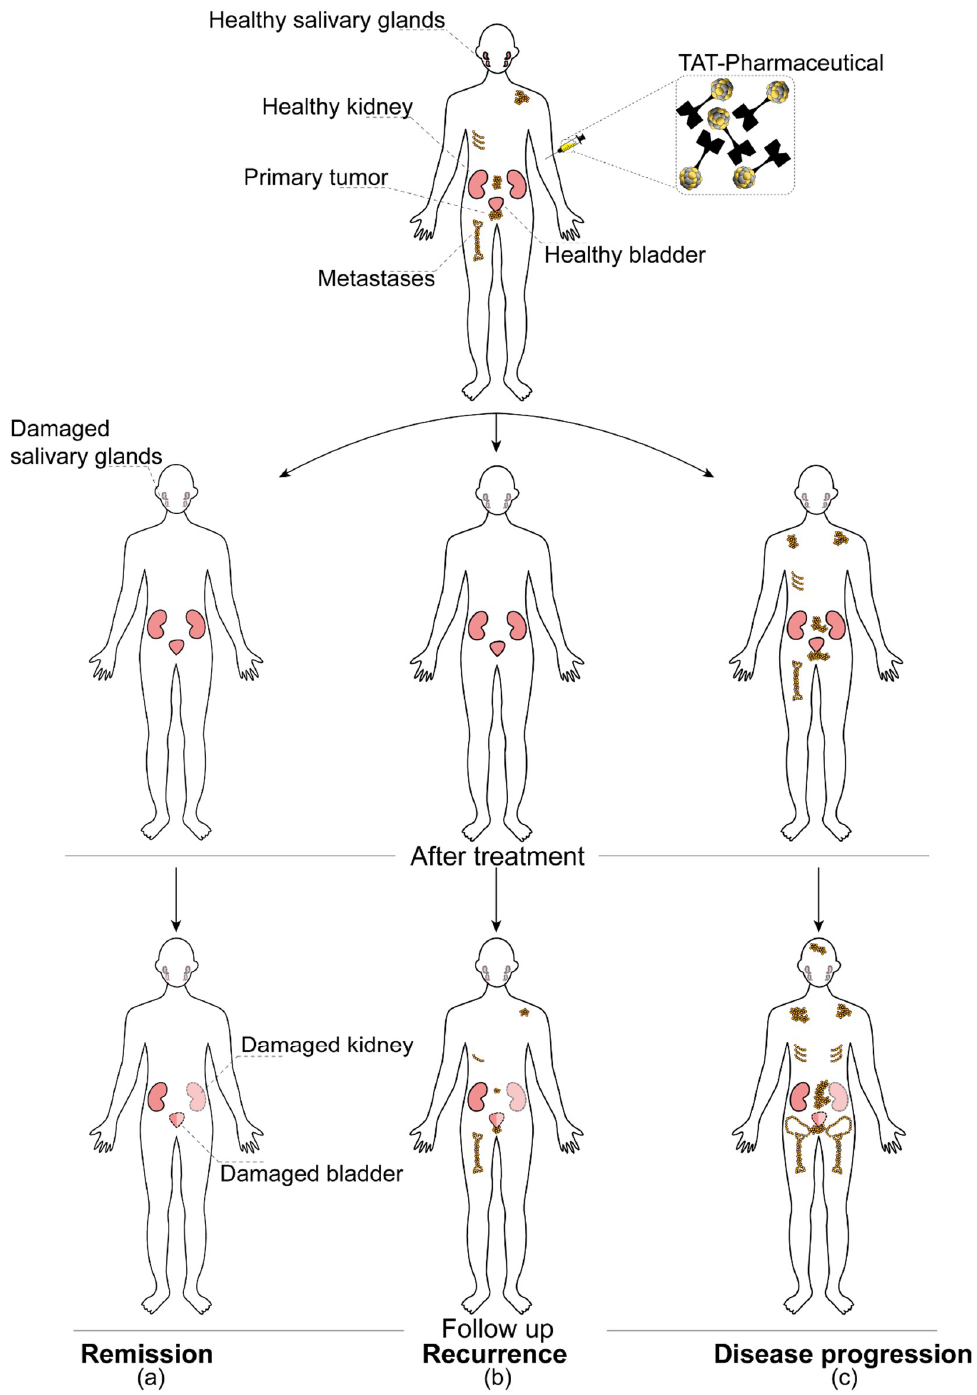
Figure 6. Possible outcomes of targeted alpha therapies. Prostate-specific membrane antigen (PSMA)-targeted alpha therapy of metastasized castration-resistant prostate cancer (mCRPC) was selected as an example for the schematic representation of three main hypothetical scenarios. These are ( a ) full and long-lasting remission, ( b ) disease recurrence after the successful outcome of the initial therapy, and ( c ) disease progression, which occurs in spite of the applied therapy (therapy resistance). In addition, possible early and late side effects, such as salivary gland, kidney, and bladder damage, are also indicated in the figure. TAT is usually applied as a third-line or salvage therapy when all other previous treatment options have failed.